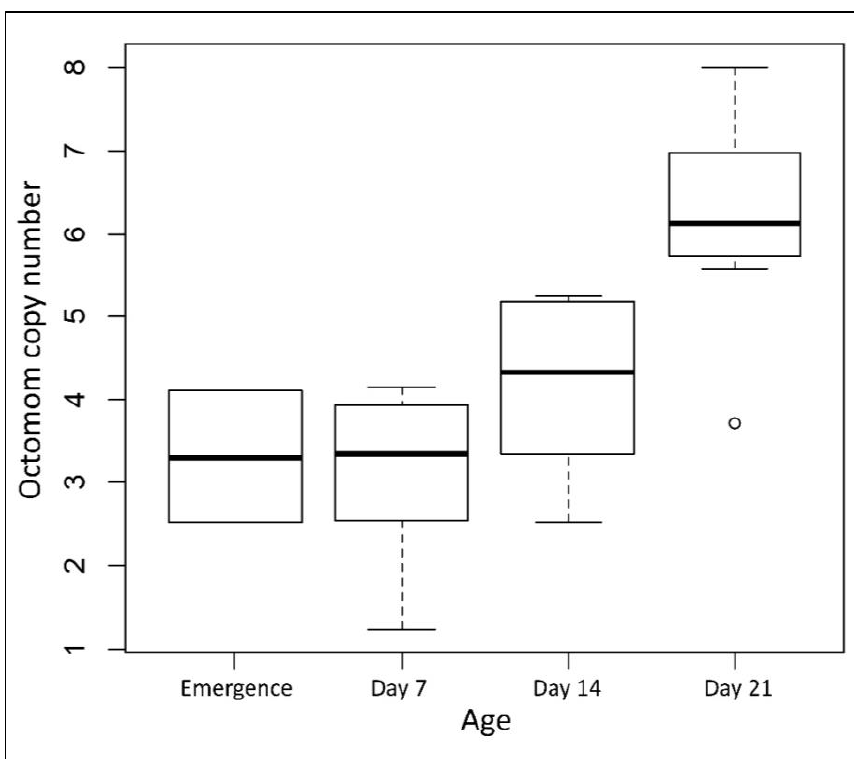
Figure 5. Relationship between the age of the fly and the octomom copy number of w MelPop. Data pooled from two treatments (paraquat and water), as neither the interaction between age and treatment (F 1,22 =2.79, p=0.11) nor the treatment effect (F 1,23 =0.14, p=0.72) were